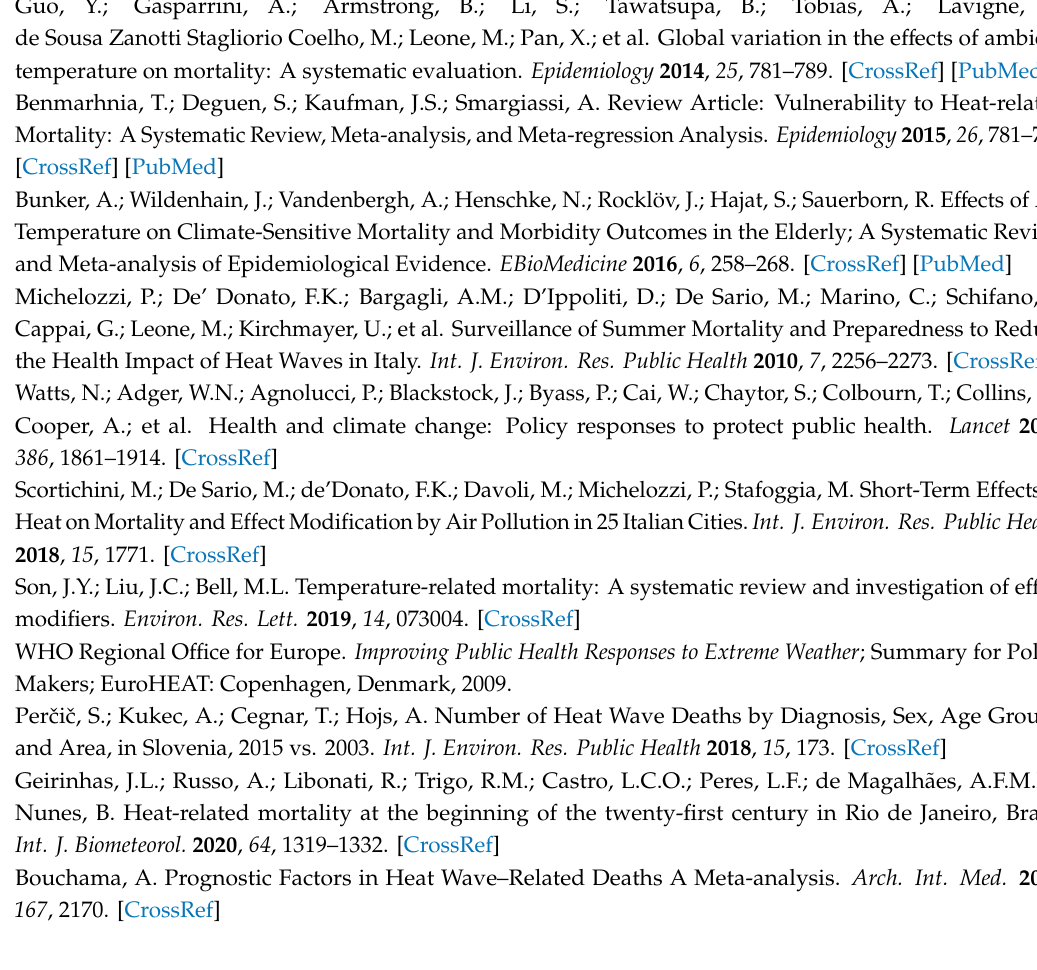
Table S1: ICD 9 and ICD 10 for the classification of the causes of death, Table S2: Classification, altitude, area and population by municipality and monitoring station attributed to each municipality with its altitude and location, Table S3: Psychiatric diagnosis group according to